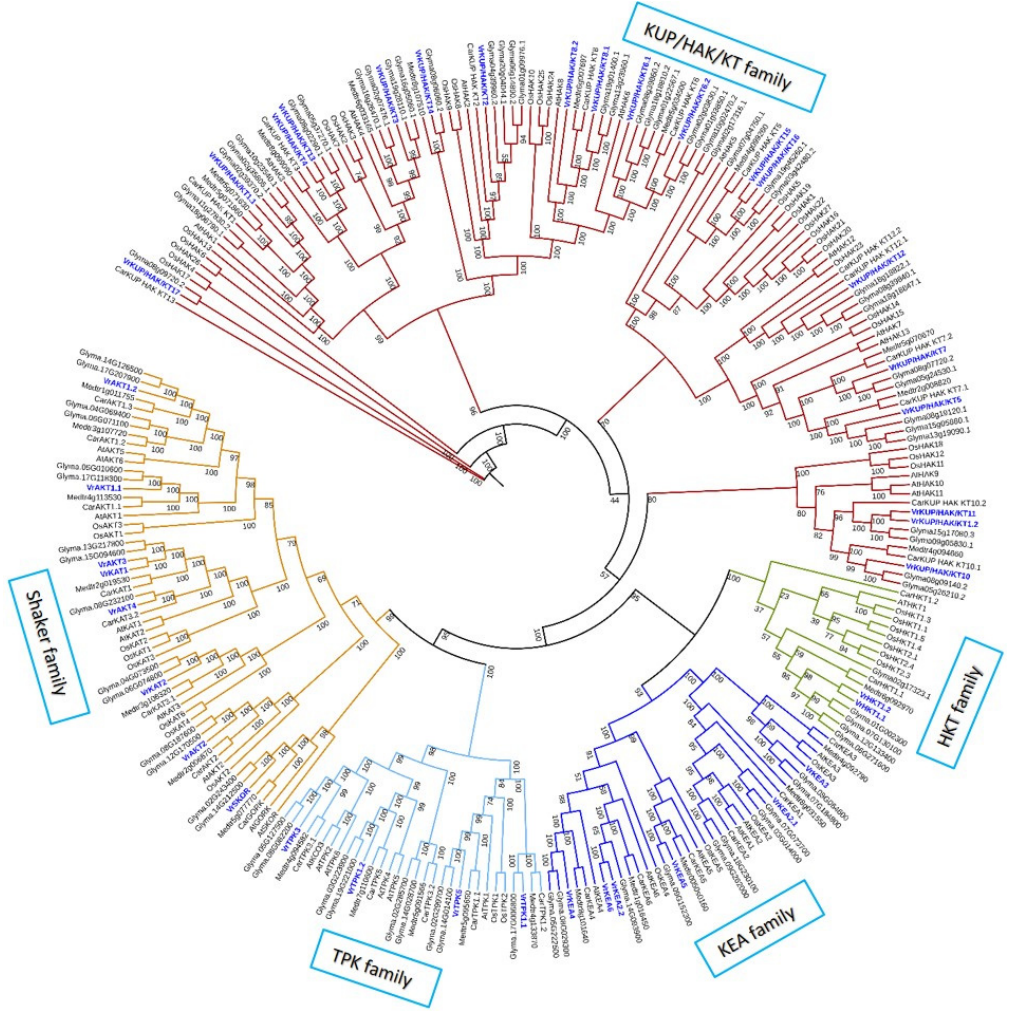
Figure 1. Neighbor-joining (NJ) tree of K + transporters and channels in V. radiata and related species. The evolutionary history was inferred from protein sequences by the neighbor-joining method, based on a JTT model. The tree with the highest log likelihood (-119897.9497) is shown. Initial tree(s) for the heuristic search were obtained automatically by applying neighbor-join and BioNJ algorithms to a matrix of pairwise distances estimated using a JTT model, and then selecting the topology with a superior log-likelihood value. Evolutionary analyses were conducted in MEGA7 [35]. The tree was visualized and edited in iTOL [36].